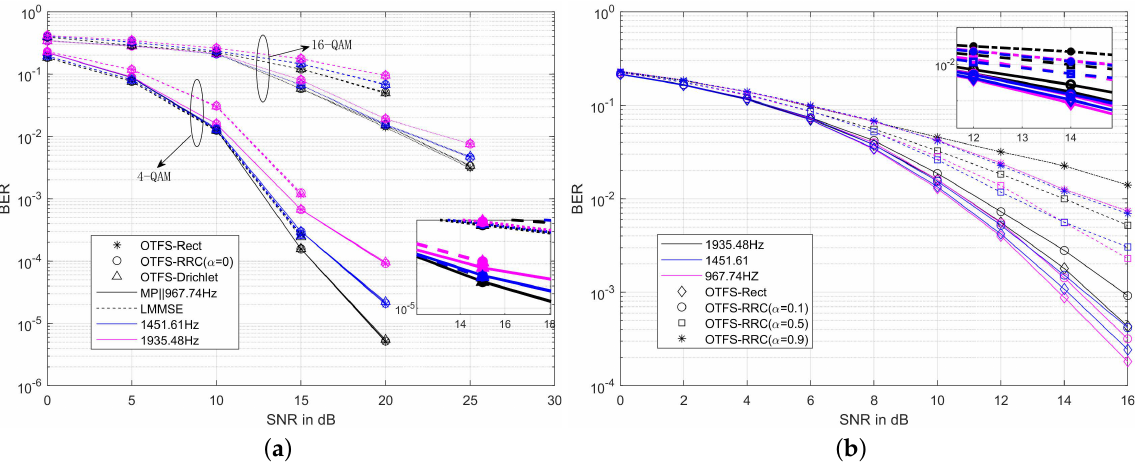
Figure 5. ( a ) BER comparison of the non-clipped OTFS-BFDM system with rectangular, RRC ( α = 0), and Drichlet PWFs; ( b ) BER comparison of the non-clipped OTFS-RRC system with α = 0.1, α = 0.5, and α = 0.9. The channels in both scenarios contain the maximum Doppler shifts of 979.74 Hz, 1451 Hz, and 1935.48 Hz.